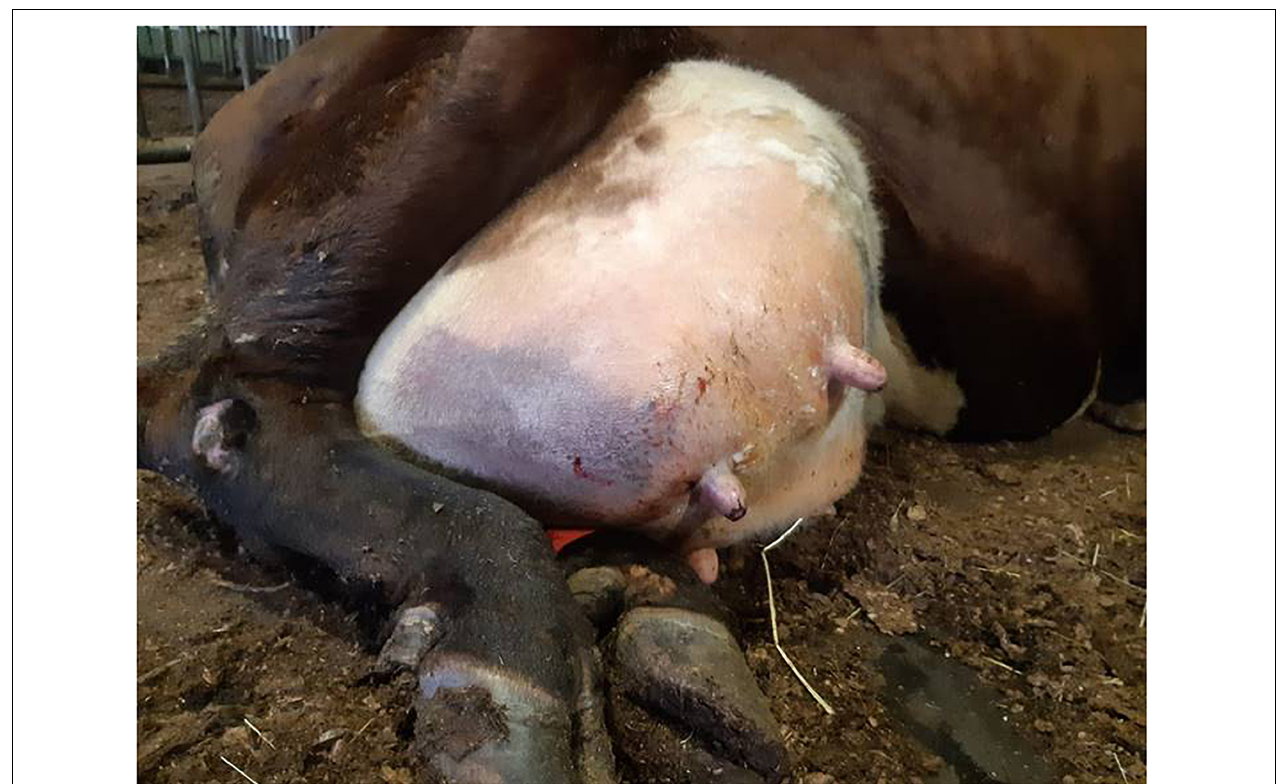
FIGURE 1 | Udder of a dairy cow suffering from peracute gangrenous Staphylococcus aureus mastitis with ischemia and blue discoloration of the affected right hind